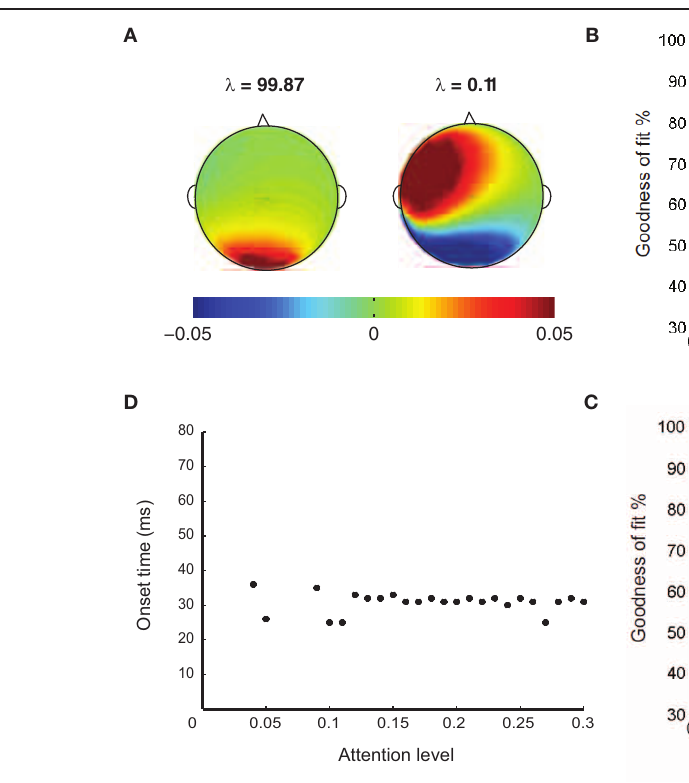
FIGURE 3 | Temporal microstructure analysis. (A) The two principal components (and corresponding eigenvalues λ ) computed from the DMS task at lowest attention level that spans the control subspace. The sum of the eigenvalues amounts to the total variance of the control condition that is capture by these two patterns. (B) The mean goodness of fit of reconstruction ( Gof ) time series plotted as a function of time when the difference in attention levels is low. The error bars at 95% significance level are also plotted as a function of time (patches). In this scenario, lack of significant recruitment results in statistically equivalent Gof over time. (C) The mean goodness Gof time series from two conditions are plotted as a